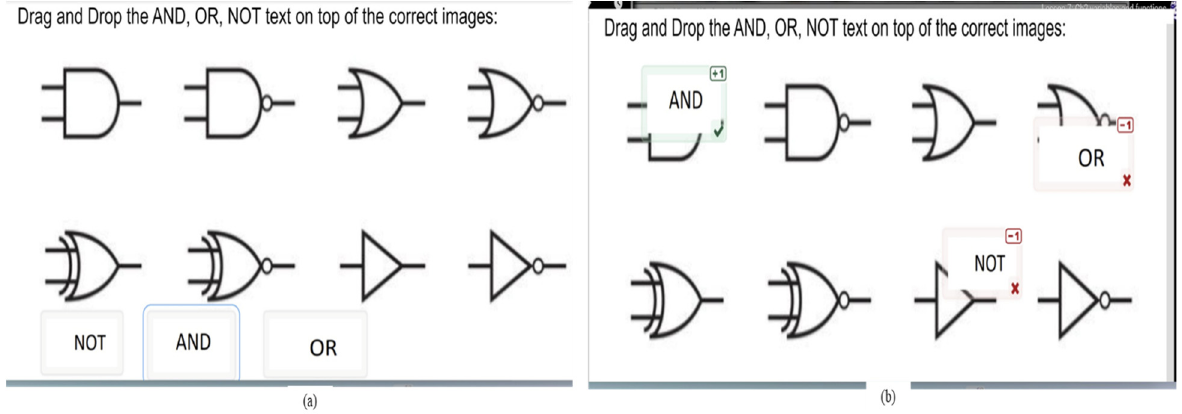
Figure 5. ( a ) Screenshot of drag and drop option in the video. ( b ) Screenshot of instant feedback option with grade points.